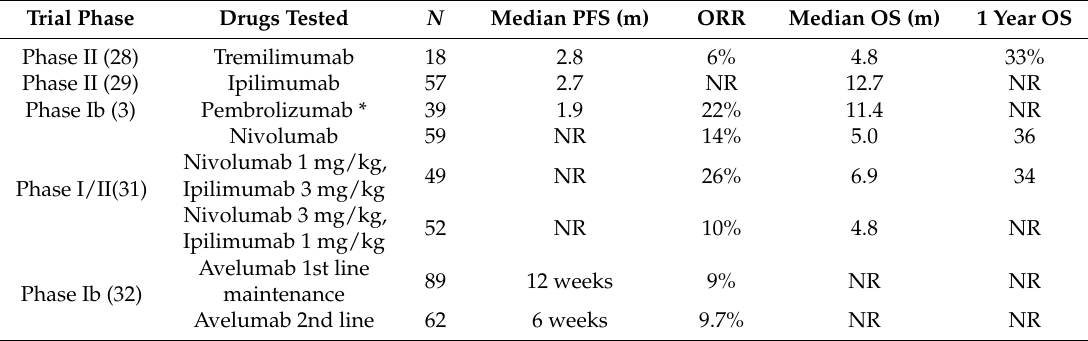
Table 1. Clinical trials investigating checkpoint inhibitors in gastroesophageal